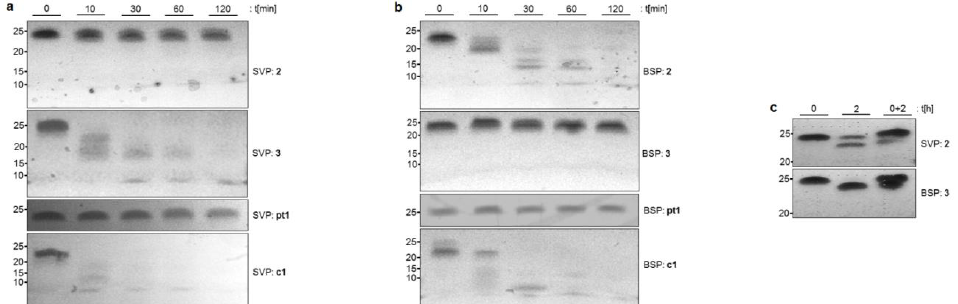
Figure 2. ( a,b ) Nuclease assays with NAA-modified oligonucleotides 2 and 3 , controls c1 and pt1 and exonucleases SVP (3 (cid:48) → 5 (cid:48) , a ) and BSP (5 (cid:48) → 3 (cid:48) , b ). ( c ) Sequencing gel analysis of the assays with oligonucleotide 2 and SVP, and 3 and BSP, respectively; left lane: assay mixture after 0 h incubation time, middle lane: assay mixture after 2 h incubation time, right lane: mixture of assay mixtures after 0 h and 2 h incubation times. In the interest of clarity, the oligonucleotide ladder indicating the lengths of the oligomers is not displayed and has been replaced with labels on the left side of the